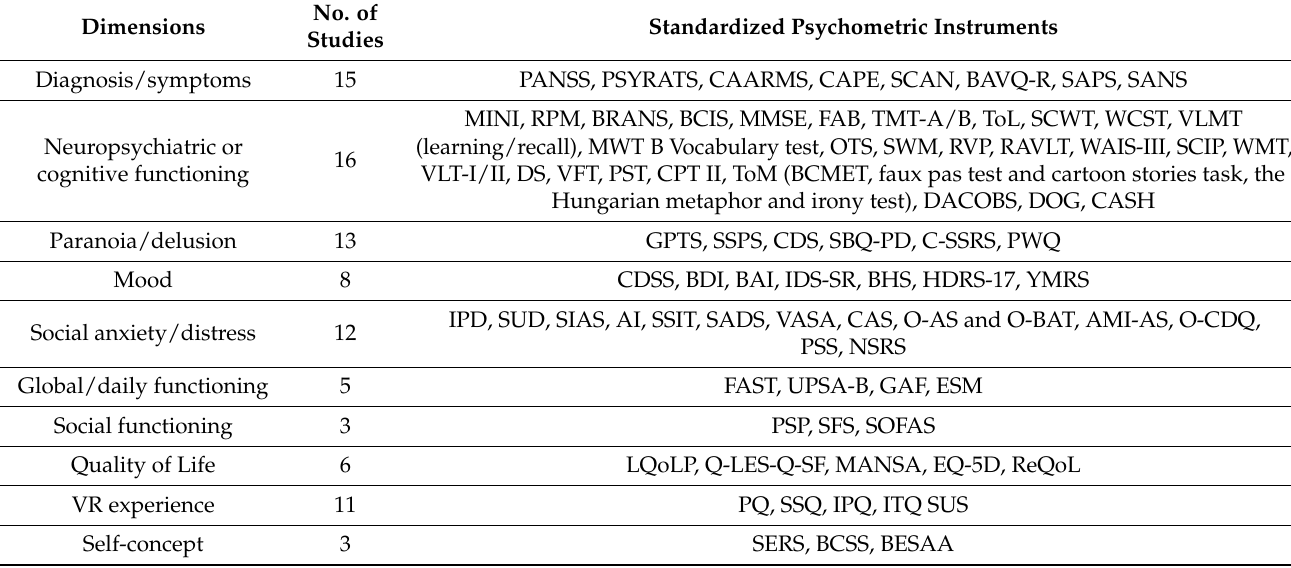
Table 3. Measurements used in different